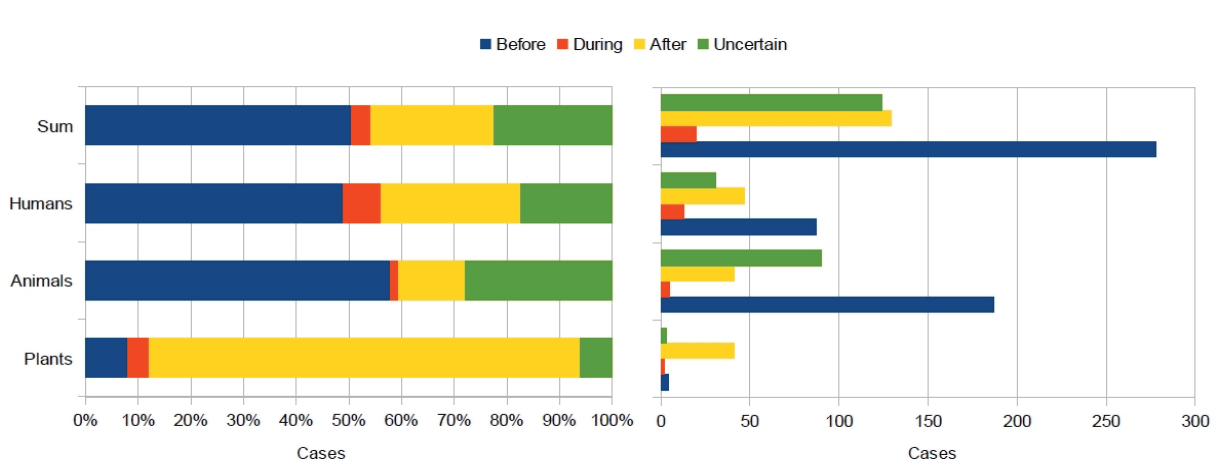
Figure 5. A summary of relative and absolute occurrence of time ordered observations with respect to the biological types, based on Tables